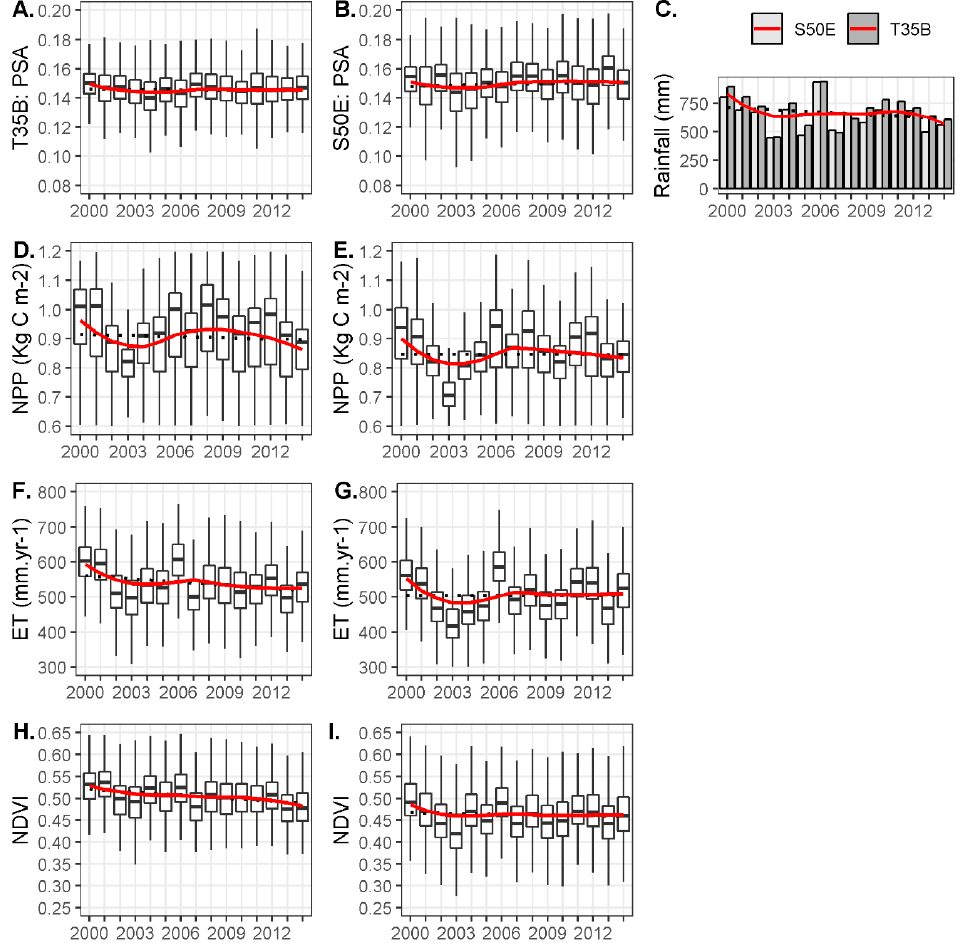
Figure 4. Mean annual PSA ( A , B ), net primary production (NPP) ( D , E ), evapotranspiration (ET) ( F , G ) and normalised difference vegetation index (NDVI) ( H , I ) values respectively for T35B ( left ) and S50E ( right ), with bar plot of annual rainfall ( C ). LOcal regression (LOESS) curve in red, linear regression curve in dotted lines.